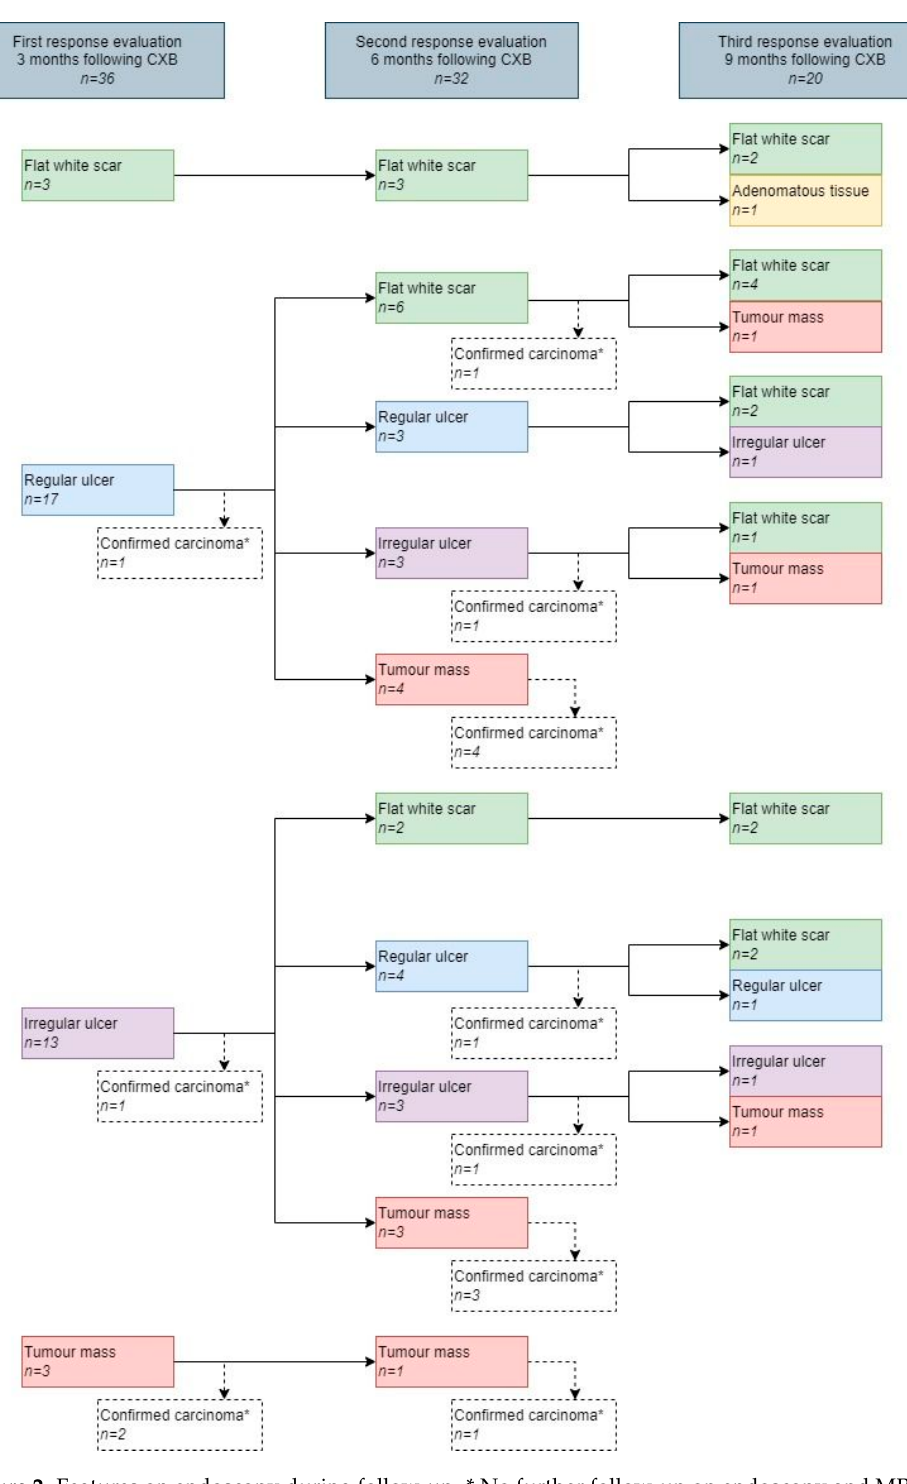
Figure 2. Features on endoscopy during follow ‐ up. * No further follow ‐ up on endoscopy and MRI of patients with histopathological confirmation of carcinoma obtained by biopsy or surgery.